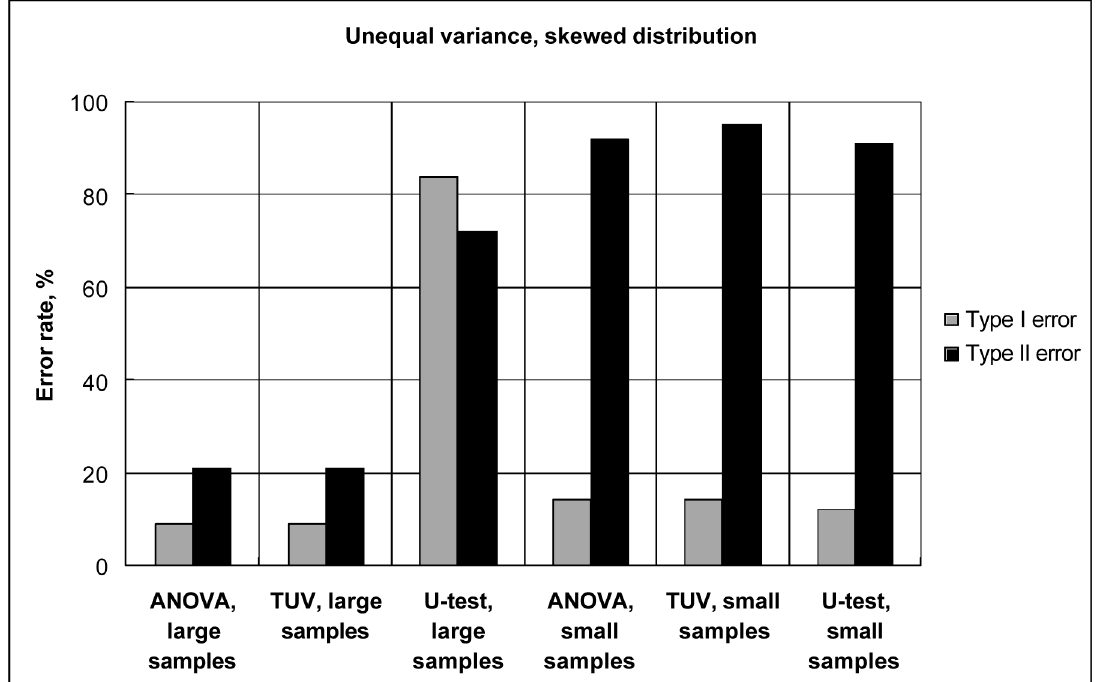
Fig. 3. Performance of statistical tests with skewed samples of even size but unequal variances. ANOVA stands for analysis of variance, TUV for t-test for unequal variances, and U-test for Mann–Whitney